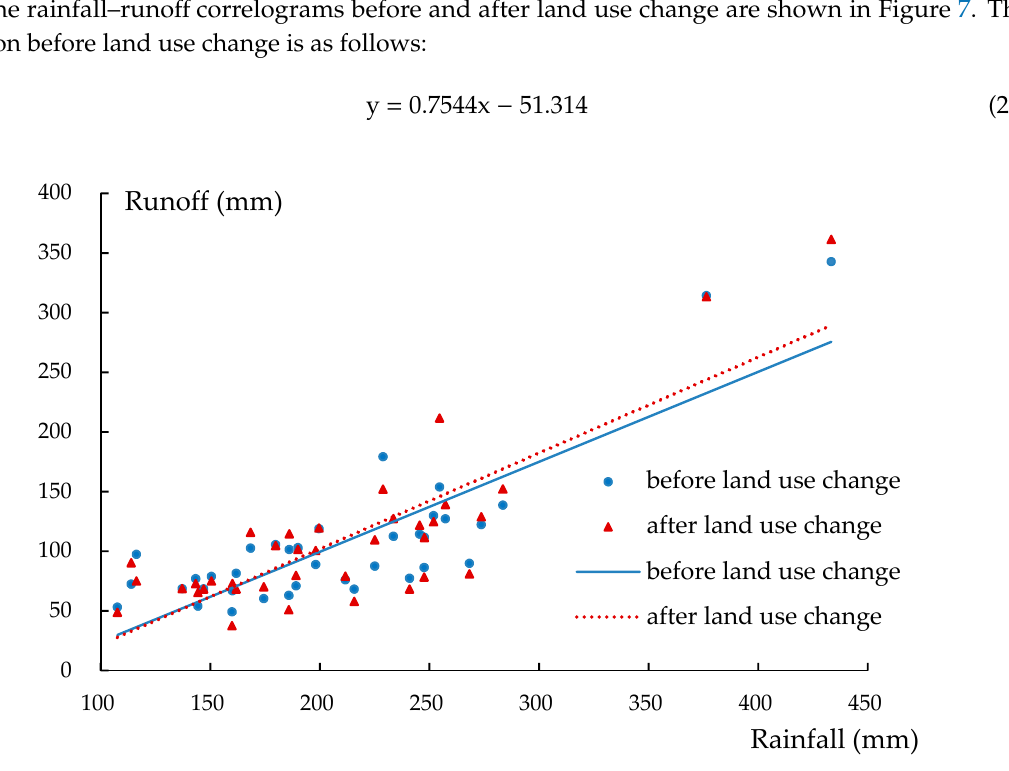
Figure 7. The relationship between precipitation and runoff depth.